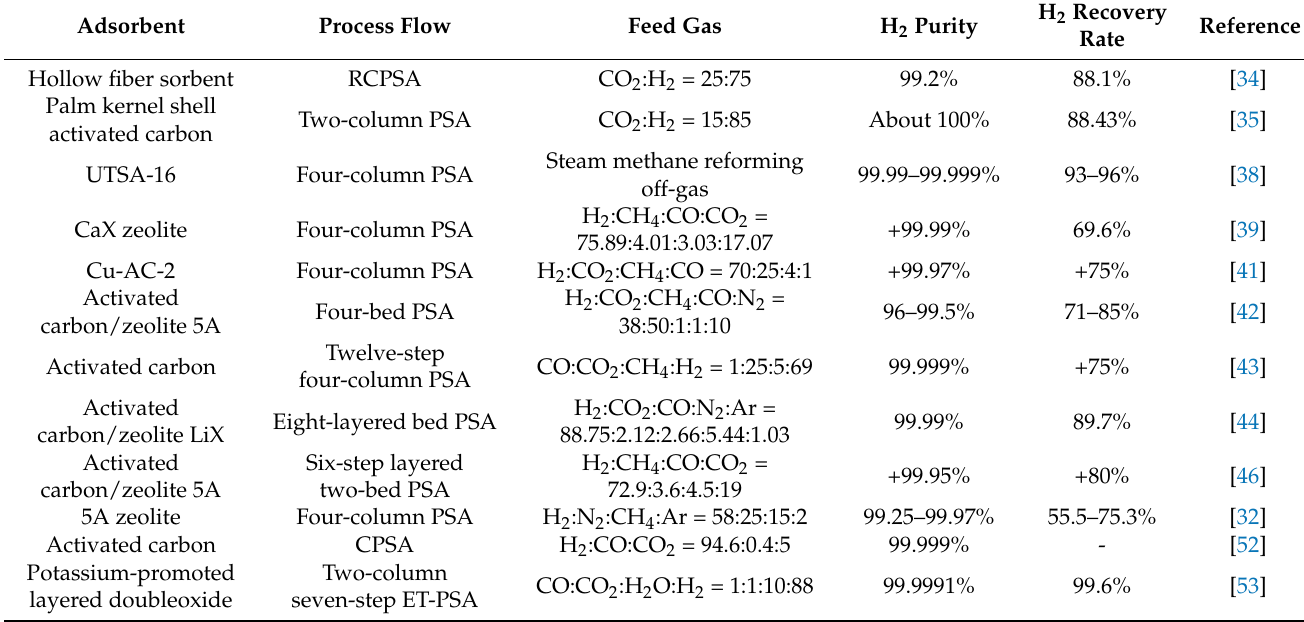
Table 5. Summary of PSA